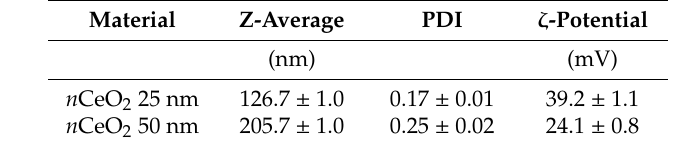
Table 1. Z-average size, relative polydispersity index (PDI) and ζ —potentials of n CeO 2 25 nm and 50 nm.